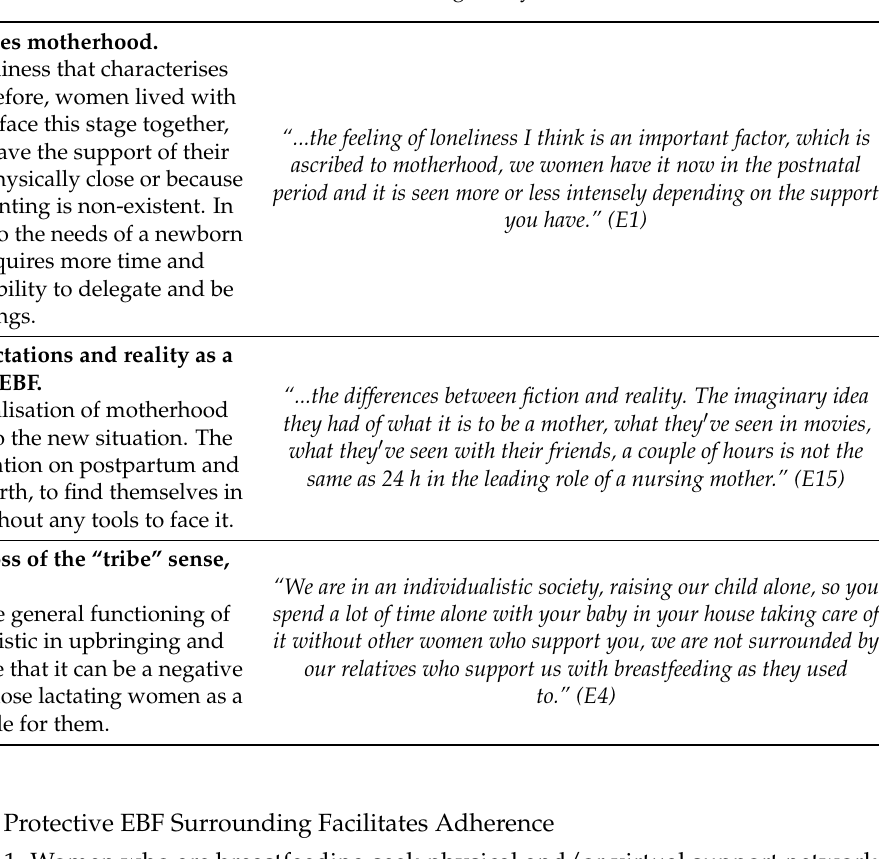
Table 3. The current social construction of motherhood can negatively affect